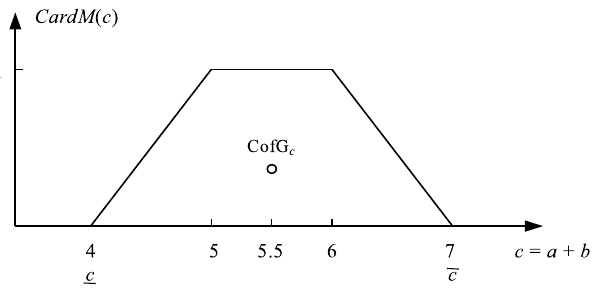
Figure 4. Normalized distribution of the cardinality measure CardM ( c ) of the set of possible result values c = a + b in the interval addition operation [ 1,2 ] + [ 3,5 ]